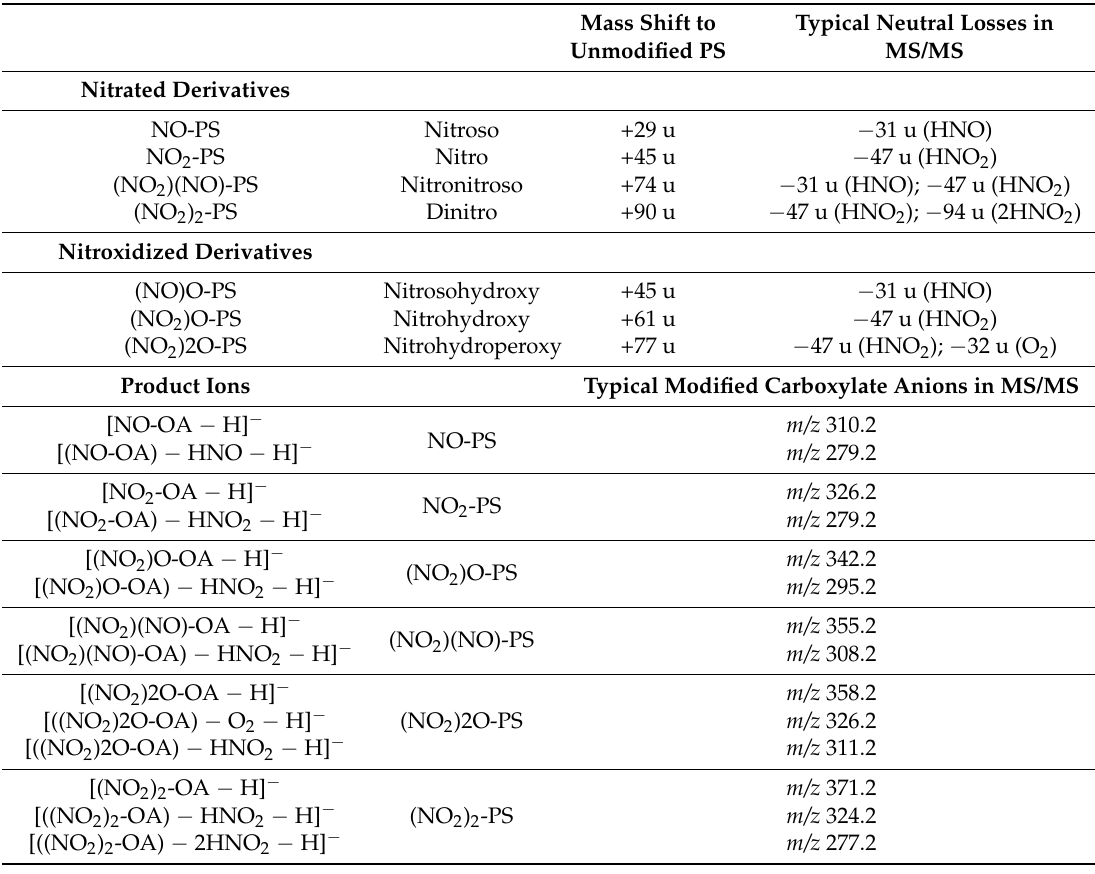
Table 2. Typical neutral losses observed in tandem mass spectra of nitrated and nitroxidized derivatives of